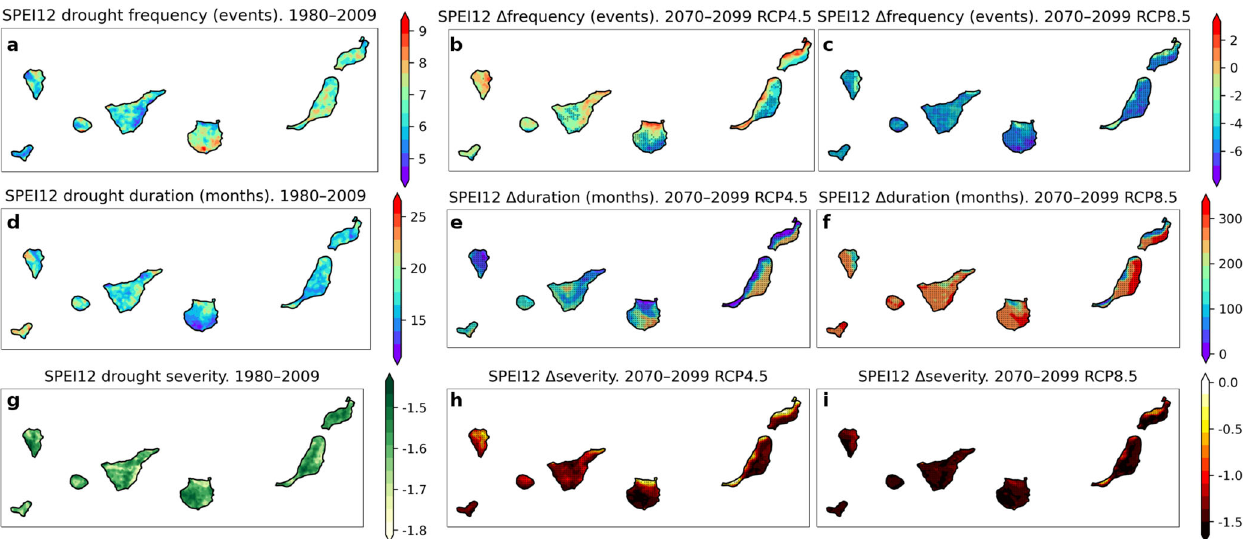
Fig. 7 Hydrological drought frequency, duration and severity in the recent past and their projected changes. Drought frequency (number of drought events in 30 years) ( a – c ), duration (months) ( d – f ), and severity (SPEI rating) ( g – i ) for the SPEI index computed at a 12-month time scale. Changes in the frequency, duration, and severity of drought events for the future (2070 – 2099), under RCP4.5 ( b , e , h ) and RCP8.5 ( c , f , i ), relative to the recent past period (1980 – 2009) ( a , d , g ). Duration and severity were obtained from values averaged for the entire period, whereas frequency is the number of events in 30 years. Dotted gridpoints correspond to robust future changes.